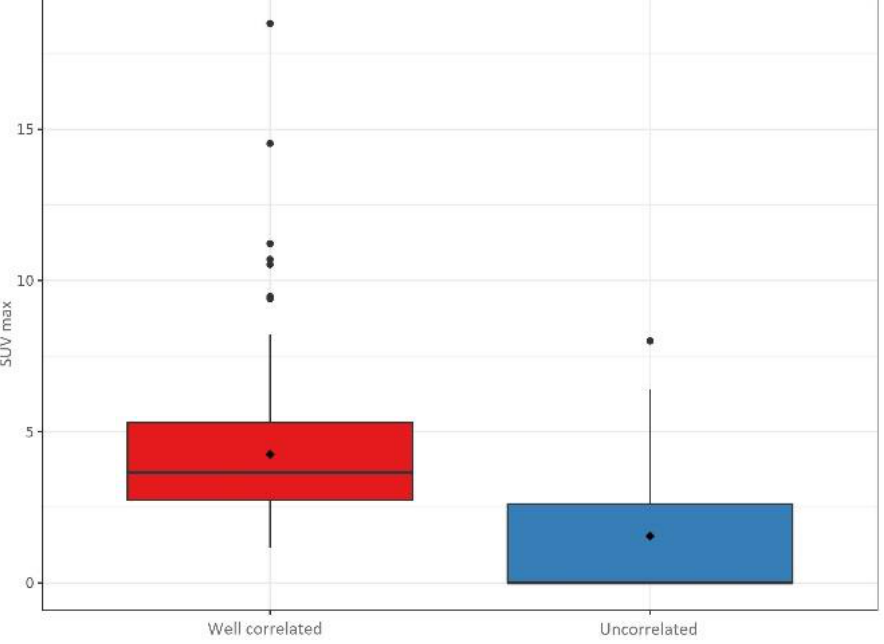
Figure 6. Number of glands detected by 18 F-choline positron emission tomography/contrast-en- hanced computed tomography in the well-correlated group ( n = 220) and uncorrelated group ( n = 49). The results of the multivariate analysis are summarised in Table 4. The odds ratios (95% confidence intervals) for SUVmax, lesion size, and number of lesions were 0.379 (0.28, 0.51), 0.703 (0.631, 0.785), and 0.151 (0.038, 0.49), respectively. The marginal effect of SUVmax was 9.8%, meaning that for every additional SUVmax point, the correlation was augmented by 9.8%. The marginal effect of lesion size was 3.3%, meaning that for every additional millimetre, the correlation was augmented by 3.3%. The marginal effect of the number of lesions was −18.8% , meaning that for every additional lesion detected, the cor- relation decreased by 18.8%.